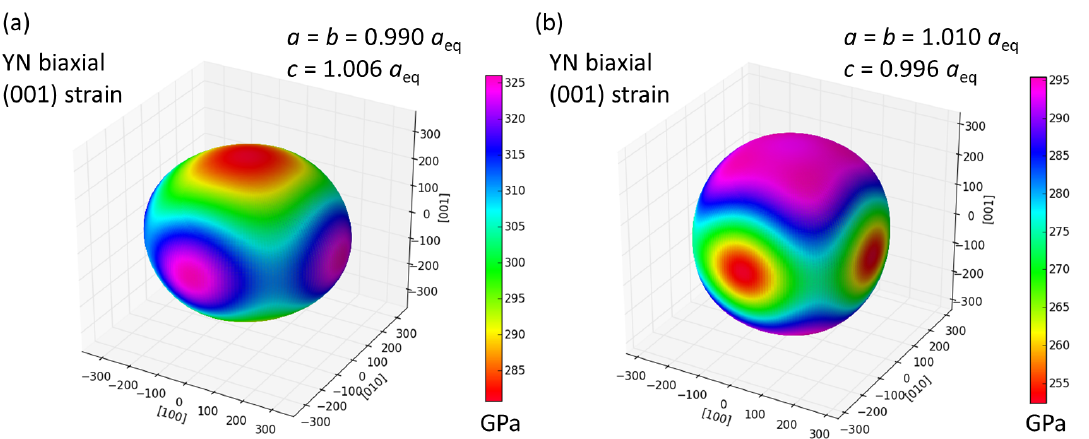
Figure 7. The calculated directional dependences of the Young’s modulus of two tetragonally deformed states of YN with a = b = 0.990 a eq ( a ) a = b = 1.010 a eq ( b ), respectively. The tetragonal lattice c parameters are equal to the values corresponding to the minimum energy (and zero stress σ c =